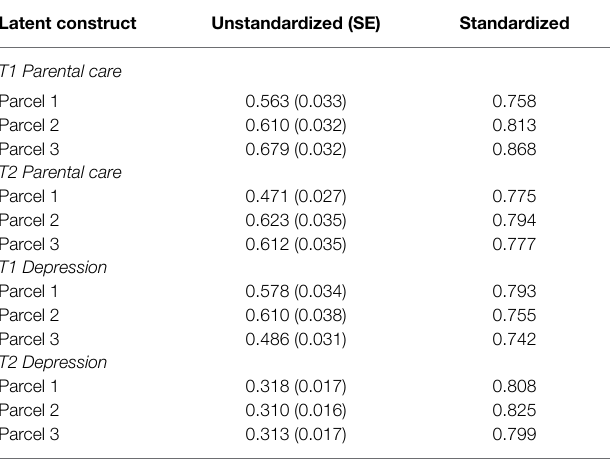
TABLE 4 | Unstandardized and standardized factor